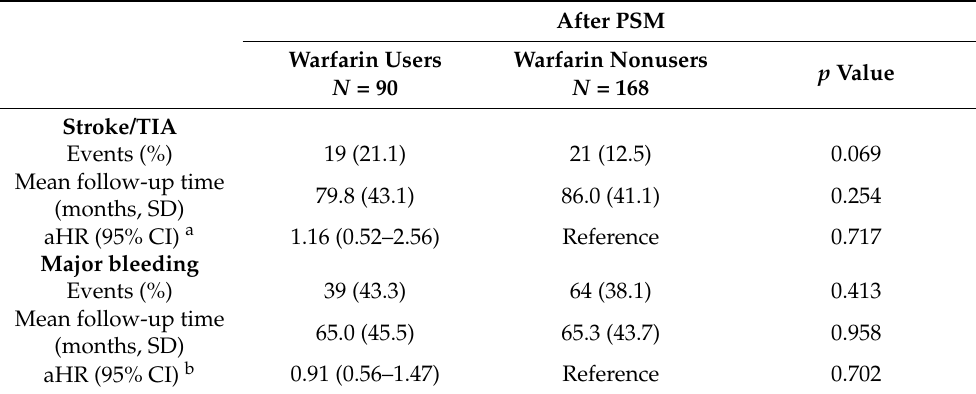
Table 2. Number of events and adjusted hazard ratios between warfarin users and nonusers among patients with hyperthyroidism-related atrial